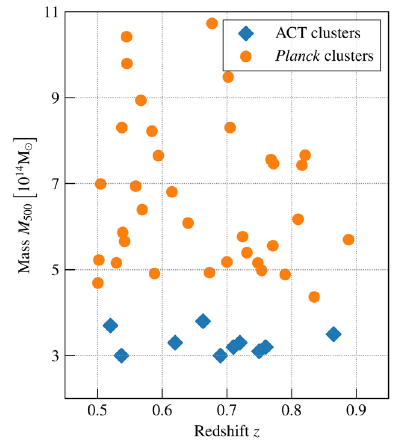
Figure 1. The NIKA2 LPSZ cluster sample presented in the mass-redshift plane, see text for details.